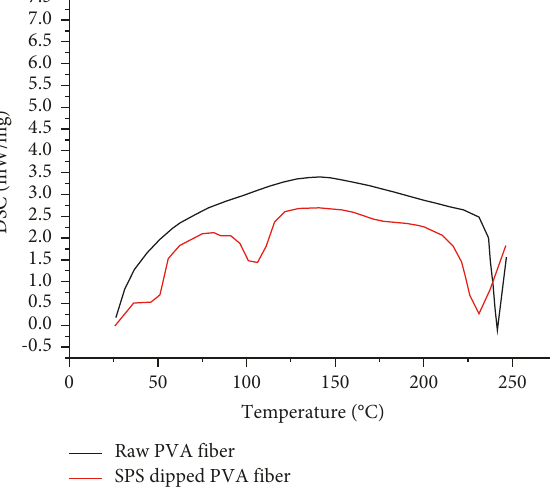
Figure 6: DSC of raw and SPS-dipped PVA fiber.